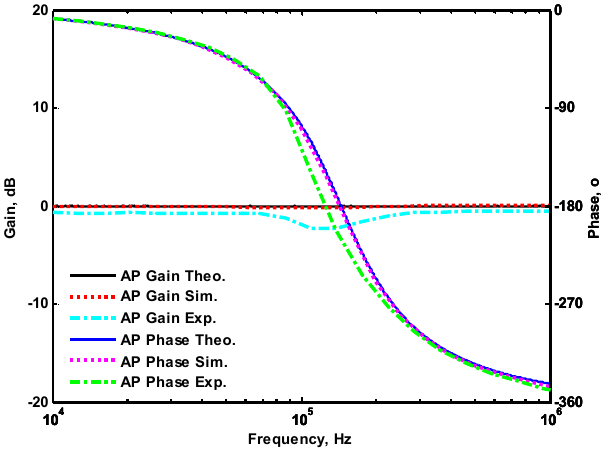
Figure 14. Experimental and simulated all-pass (AP) filters with theoretical responses in case II.